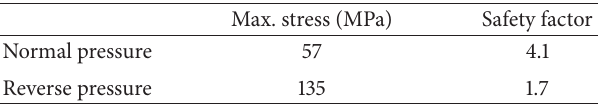
Table 2: Acceleration values of the SSE load according to the KEPIC MFA.